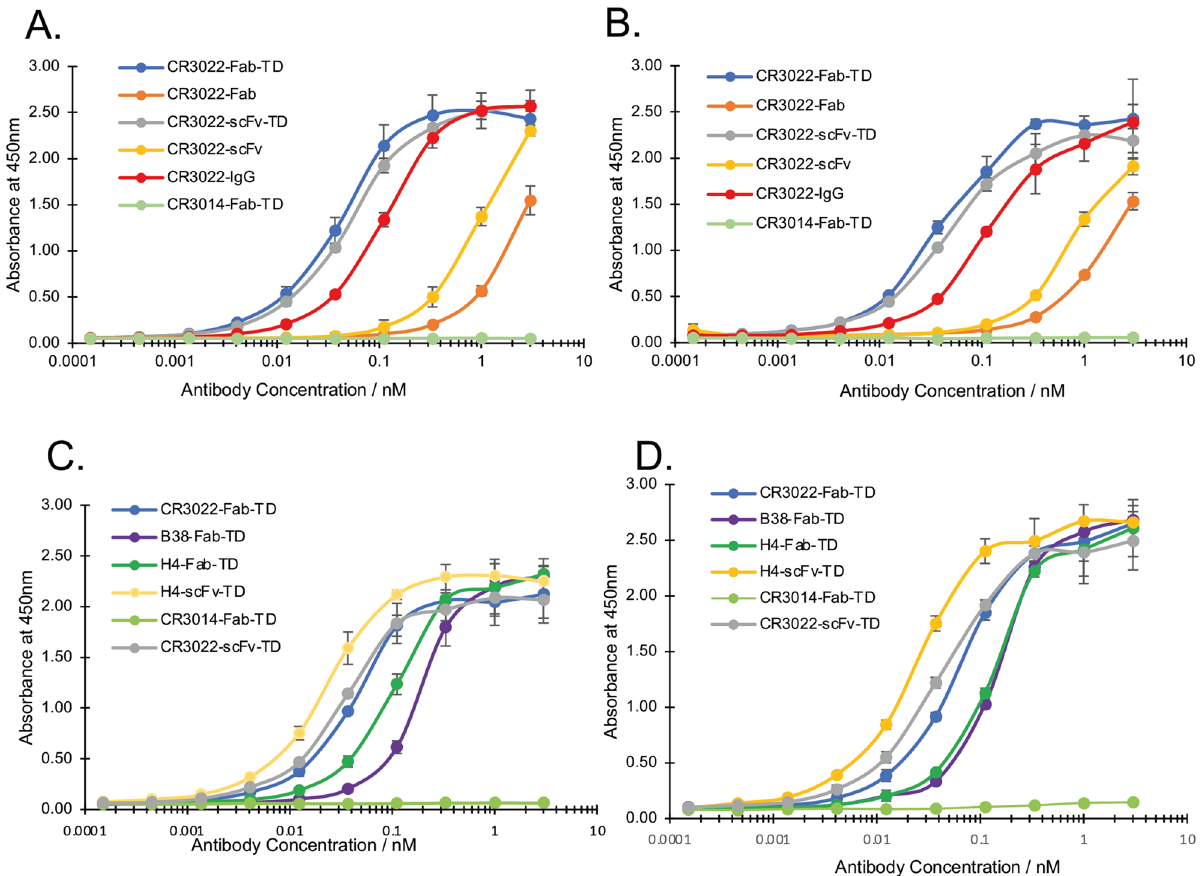
Figure 3. Direct ELISA immunoassays with anti-SARS-CoV-2 antibodies detecting viral spike proteins. The ability and potency of engineered anti-SARS-CoV-2 antibodies to bind to the viral spike proteins was compared using Enzyme-linked immunosorbent assays (ELISAs). SARS-CoV-2 spike protein as either S1 (A,C) or RBD (B,D) was adsorbed onto immunoassay plates at 2 µg per µL for 16 h at 4 C. Wells were thoroughly washed, blocked, and various concentrations of the indicated His-tagged antibodies were added to each well and incubated for 16 h at 4 C, followed by washing and incubation with anti-His-HRP antibody for 2 h at room temperature. Colour was developed using TMB and absorbance read at 450λ. All samples were run in The consequence of tetramerization was also tested with binding of the H4 and B38 mAbs, comparing interac- tion of H4-Fab-TD or H4-scFv-TD with CR3022-Fab-TD or CR3022-scFv-TD with the SARS-CoV-2 S1 spike protein (Fig. 3C) or the RBD (Fig. 3D). We observed the most potent Quad antibody was the H4-scFv-TD (50% binding about 0.02 nM) substantially better than CR3022-scFv-TD (50% binding about 0.05 nM). The H4 or B38 Fab-TD proteins did not have especially potent binding curves, displaying 50% binding at about 0.1 nM and 0.2 nM respectively. The increase in functional affinity in the reformatted H4 and CR3022 was emphasized by comparison of their scFv-TD forms with the H4-scFv or the CR3022-scFv and of Fab-TD with CR3022-Fab (respectively Supplemen- tary Fig. 3A,B). The Quads saturate spike protein binding at lower molarity than the scFv or Fab counterparts. The antigenic epitopes on the SARS-CoV-2 spike protein for CR3022, H4 and B38 antibodies does not overlap 12 . It was possible therefore that the enhanced mAb tetramers could give additive effects for detection of the virus protein. This was assessed in ELISA binding of mixtures of CR3022 Fab-TD, B38-Fab-TD and H4-Fab-TD to SARS-CoV-2 RBD or S1 compared to CR3022-Fab-TD alone (respectively Supplementary Fig. 3C,D). We did not observe additive effects, probably because of steric hindrance of the bulky antibody tetramers binding to the spike protein antigens in proximity. We further evaluated the potential of employing anti-SARS-CoV-2 CR3022 mAb in viral antigen detection systems. The spike protein detection levels were determined in a sandwich ELISA using, as capture proteins, a dimeric version of the extracellular domain of SARS-CoV-2 receptor ACE2-Fc 29 (Supplementary Fig. 3E) or a tetrameric version (ACE2-Fc-TD) 30 (Supplementary Fig. 3F). The CR3022 Fab-TD and scFv-TD tetramers displayed the highest signal performing with higher efficacy than the CR3022 IgG1 in various situations (Sup- plementary Fig. 3E–H) . In all ELISA data, the non-binding CR3044 served as negative control, as predicted from published binding data 8 .